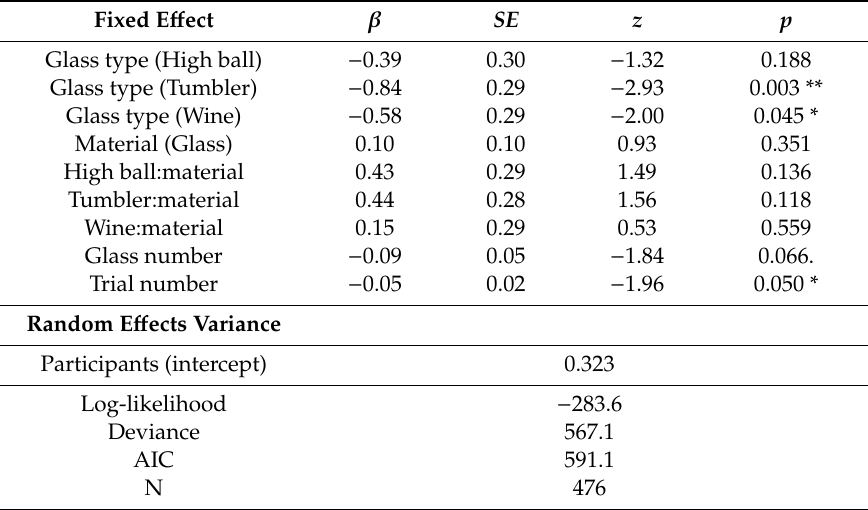
Table 1. GLMM output for putdown 1, where the empty glass is placed in the filling zone. Structure of model reported here: glmer(guidance ~glass type*material + glass number + trial number + (1 + trial number || participant)).